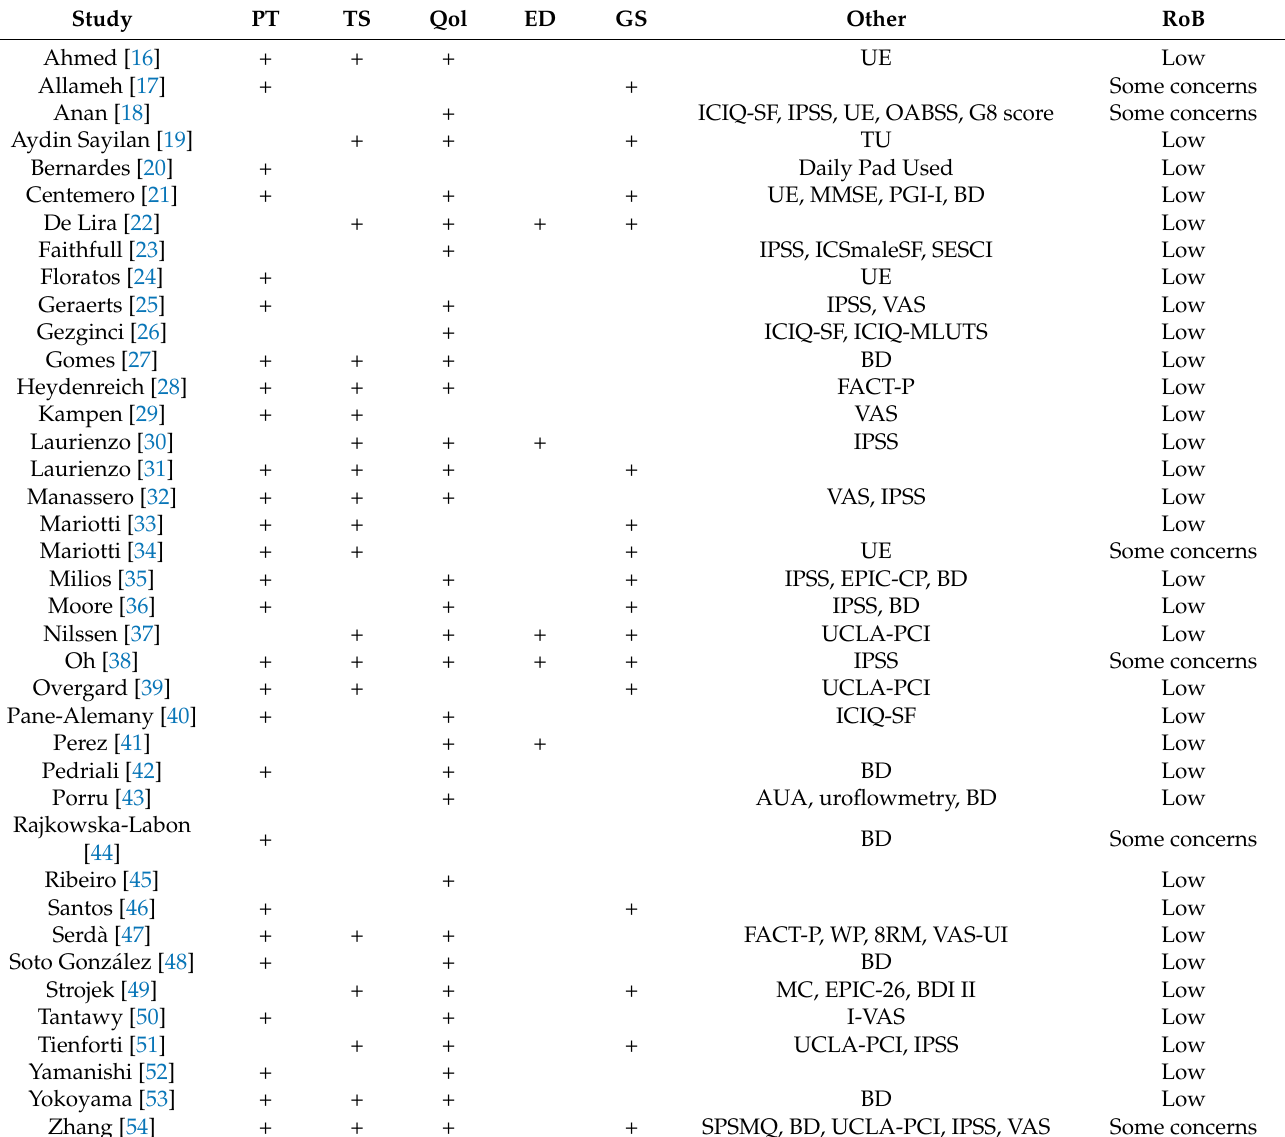
Table 1. Characteristics of outcome measures of studies of physiotherapy in male urinary incontinence that qualified for this